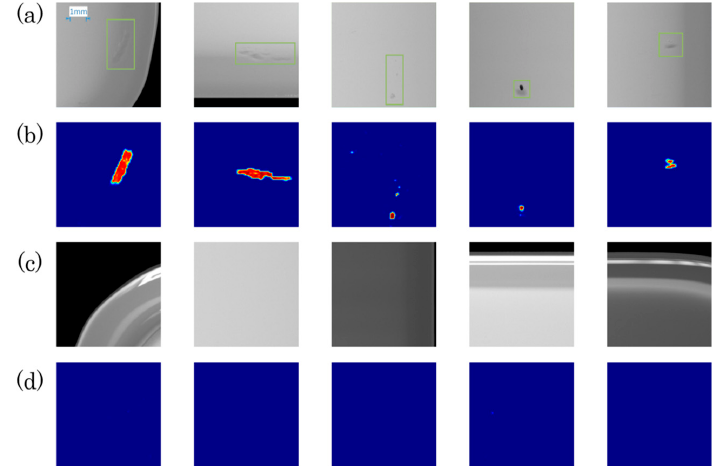
Figure 10. Segmentation results of discoloration defects and negative samples: ( a,b ) are the respectively acquired defect images and segmentation results of discoloration; ( c,d ) are the respectively acquired defect images and segmentation results of negative samples.